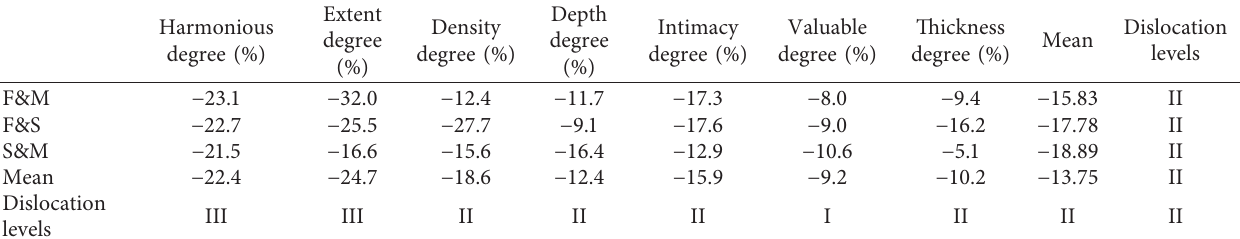
Figure 3: Bilateral analysis of different roles’ relationship quality. Note. R1 ∼ R6 represent, respectively, harmonious degree, extent degree, density degree, depth degree, intimacy degree, valuable degree, and thickness degree. Table 6: Dislocation levels analysis of different roles’ relationship